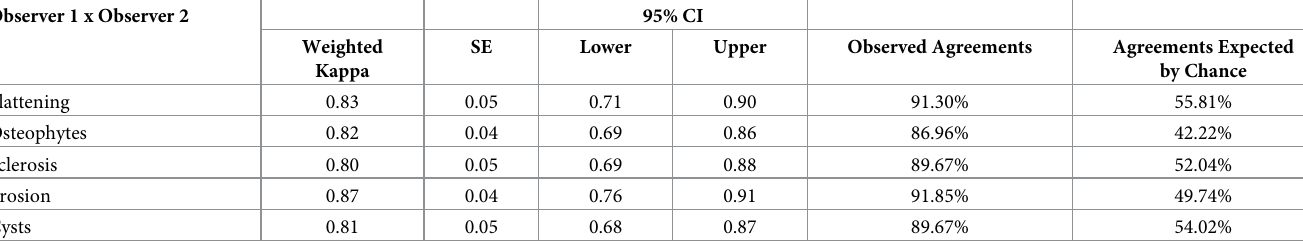
Table 2. Cohen’s Kappa statistic to test inter-rater reliability between the